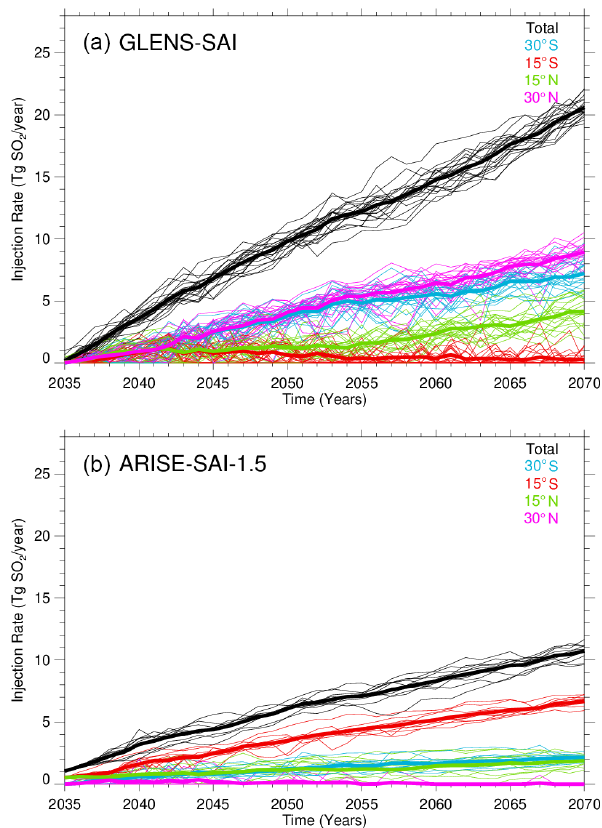
Figure 1. Evolution of yearly sulfur dioxide injec- tions (TgSO 2 yr − 1 ) over time at the four injection latitudes for (a) GLENS-SAI and (b) ARISE-SAI-1.5 from 2035 to